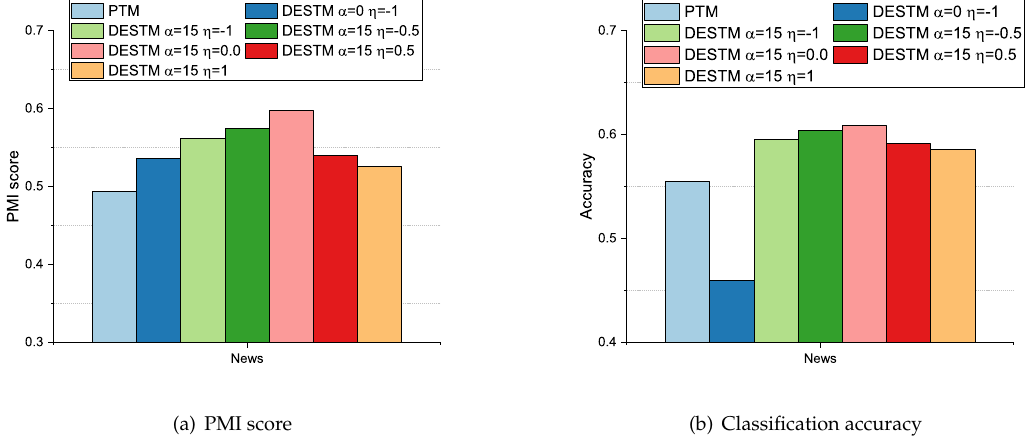
Figure 4. Comparison results between models with complete and partial document